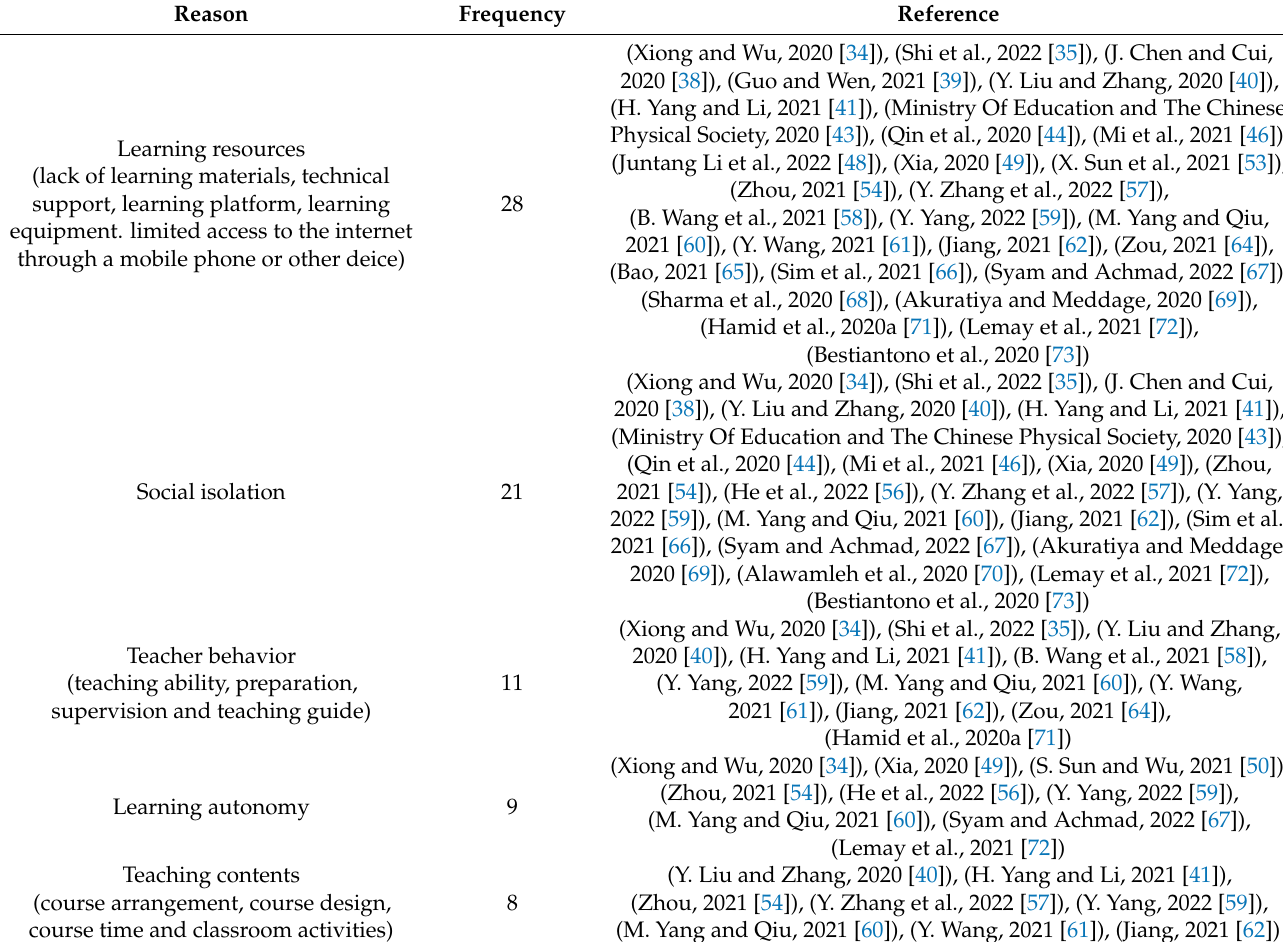
Table 2. Summary for self-reported reasons to negatively evaluate online learning from previous